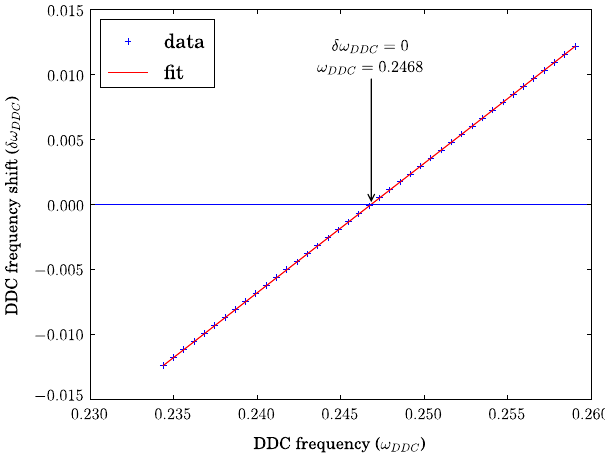
FIG. 10. Plot of the down-converted signal frequency (cid:2)! as a function of digital oscillator frequency !